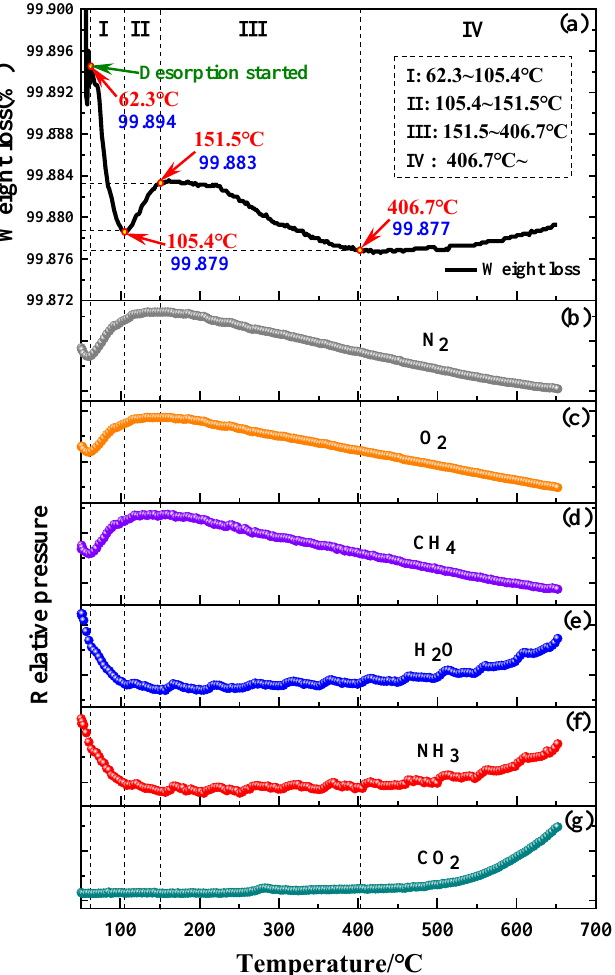
Figure 1. Thermogravimetric analysis curve of as-prepared powder ( a ) and desorption curves of adsorbed gases on the powder surface ( b – g ).